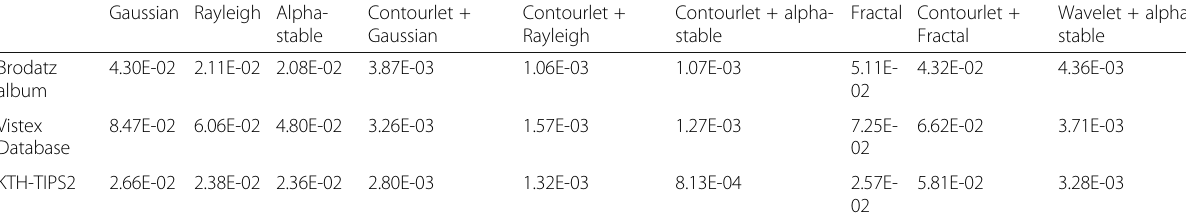
Table 3 Standard deviation of segmentation accuracy for different methods (without noise) Gaussian Rayleigh Alpha-